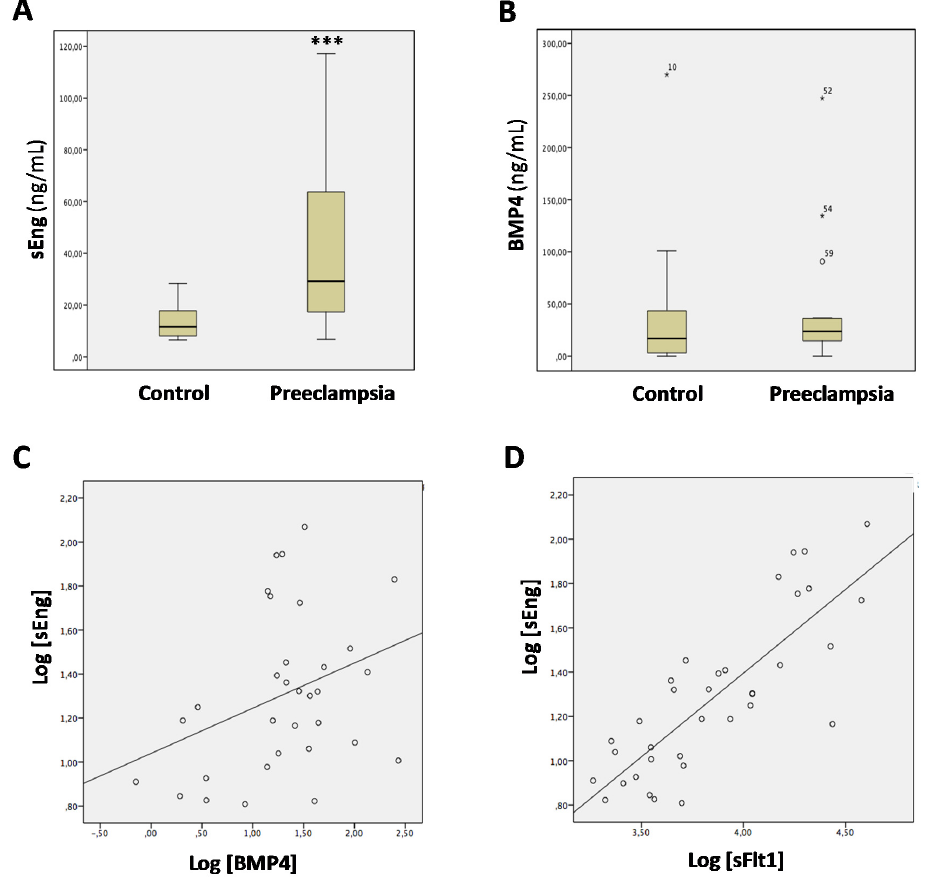
Figure 3. Correlation between sEng and BMP4 levels in sera from pregnant women. Sera from pregnant women without (control; n = 19) or with preeclampsia ( n = 16) were analyzed by ELISA to determine protein levels of sEng ( A ; *** p = 0.001), BMP4 ( B ; p = 0.13) and sFlt1. In panel B , the presence of high-outliers (* , ◦ ) is indicated. Correlation analysis between sEng and BMP4 levels ( C ; r = 0.35, p = 0.03), and between sEng and sFlt1 levels ( D ; r = 0.81, p < 0.0001) are shown.